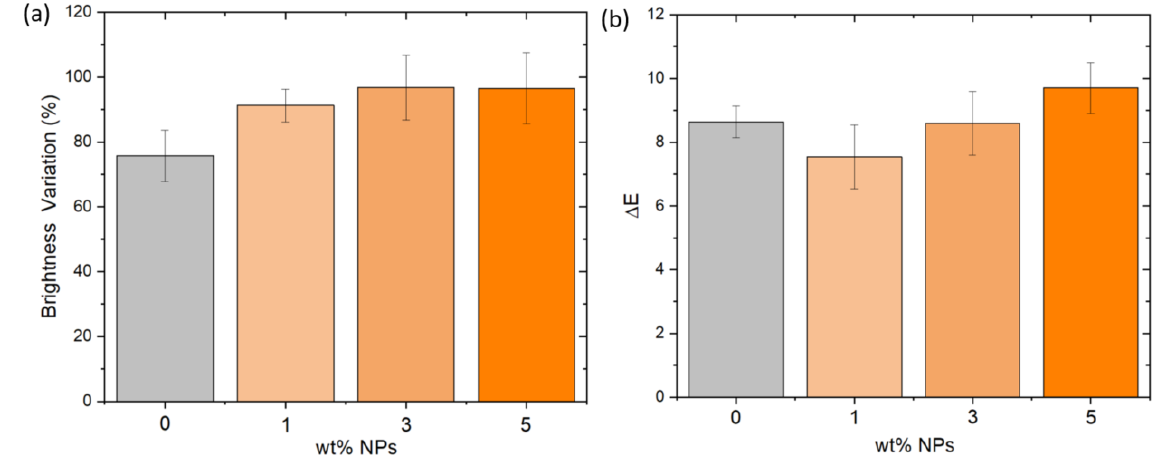
Figure 10. ( a ) Brightness variation and ( b ) color changes of the different samples.